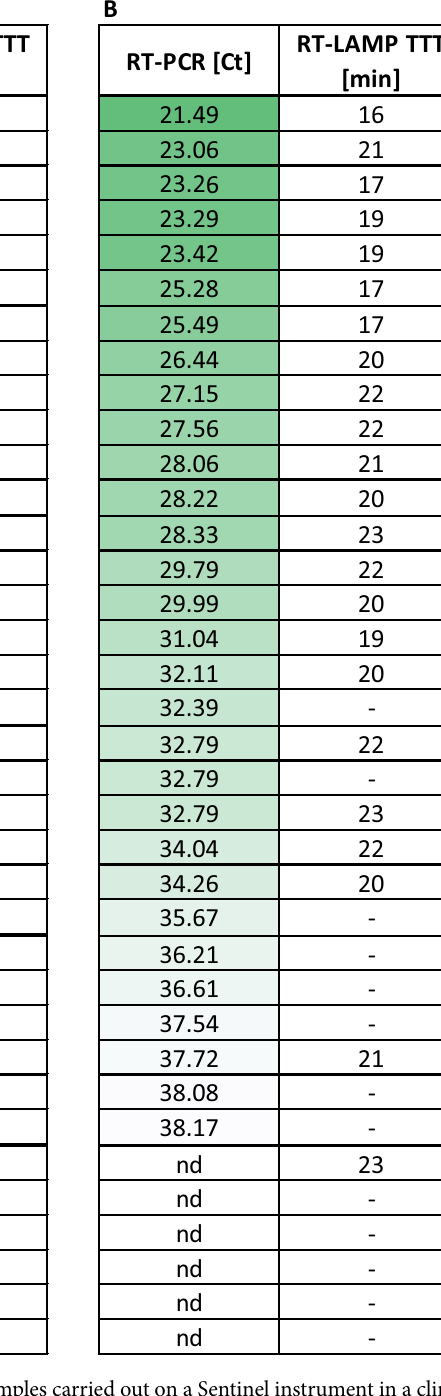
Table 4. RT-LAMP limit of detection in saliva samples carried out on a Sentinel instrument in a clinical pathology laboratory. Six SARS-CoV-2 saliva samples with different viral loads were serially diluted 1:10